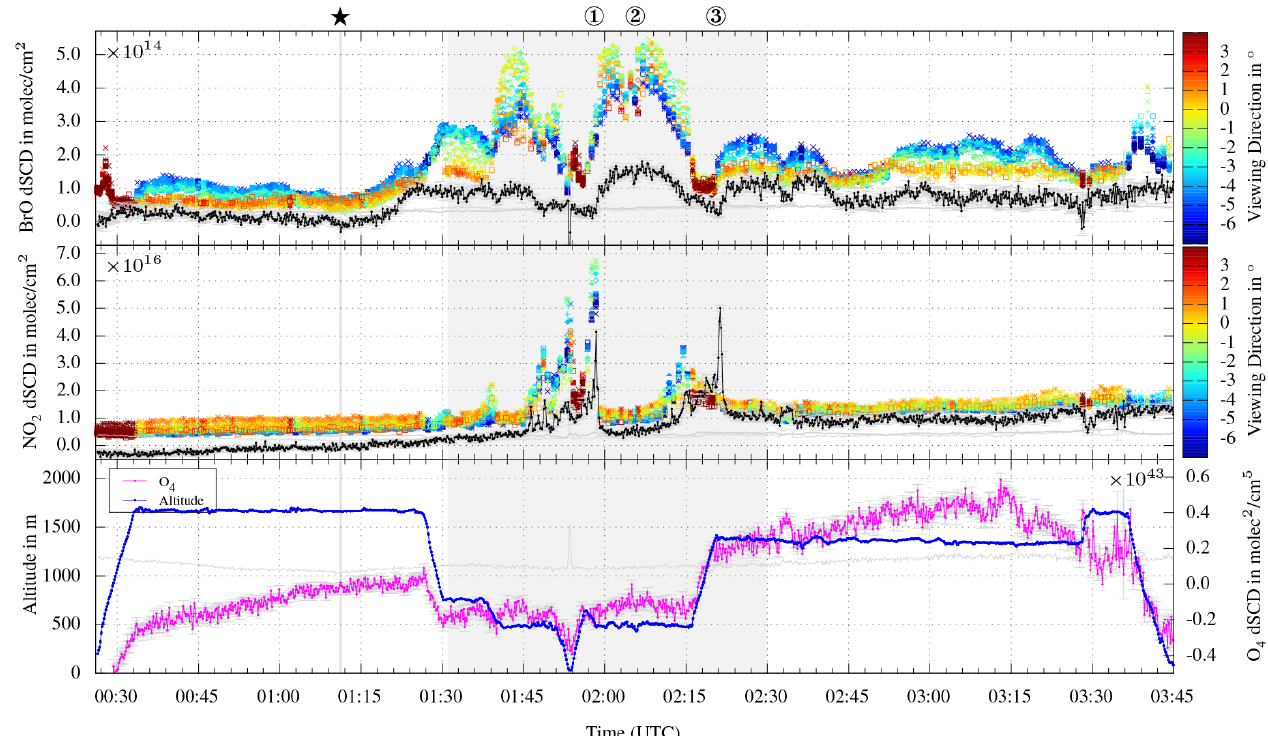
Figure 21. Time series of measurement data from the flight on 31 March 2012 between 00:25 and 03:45UTC. Shaded in gray is the section of the flight around Prudhoe Bay, Alaska, which is also shown in Fig. 22. Forward (color-coded points) and nadir (solid black lines) measurements show enhanced BrO over the sea ice, around Northstar Island ( › ) and an anti-correlation with the observed NO 2 values ( ‹ , fi ). Errors and detection limits are plotted in gray. H : Time of in-flight reference spectrum for nadir